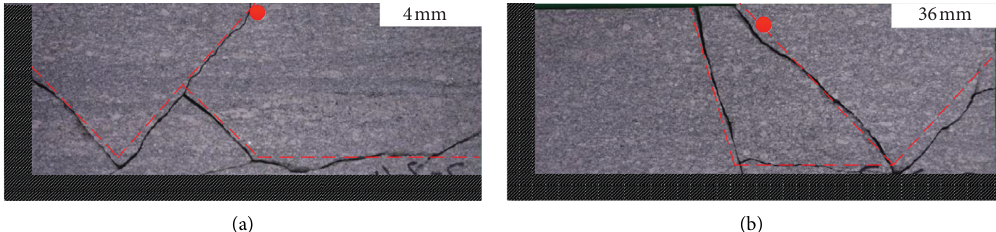
Figure 23: The cutting results of granite with different cutting depth. (a) 4mm and (b) 36mm.